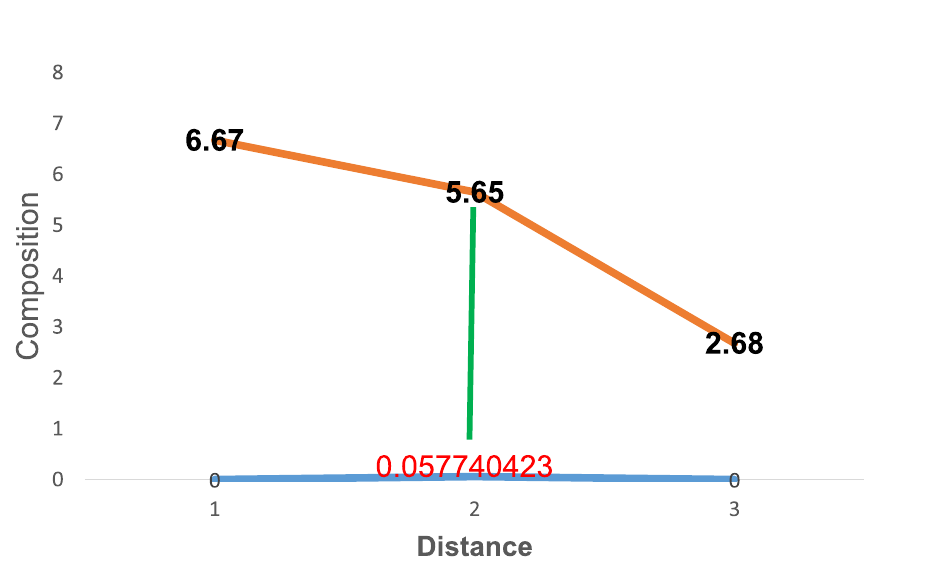
Figure 7. Diffusion of carbon atoms into the surface of grey cast iron at 900° for 210